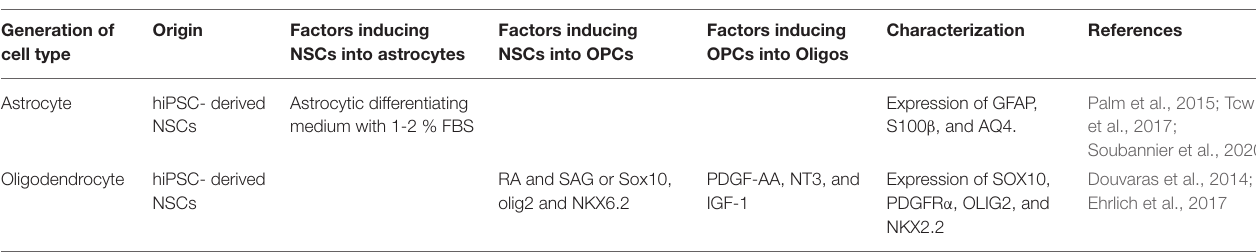
TABLE 2 | Differentiation of glial subtypes from human hiPSC-derived